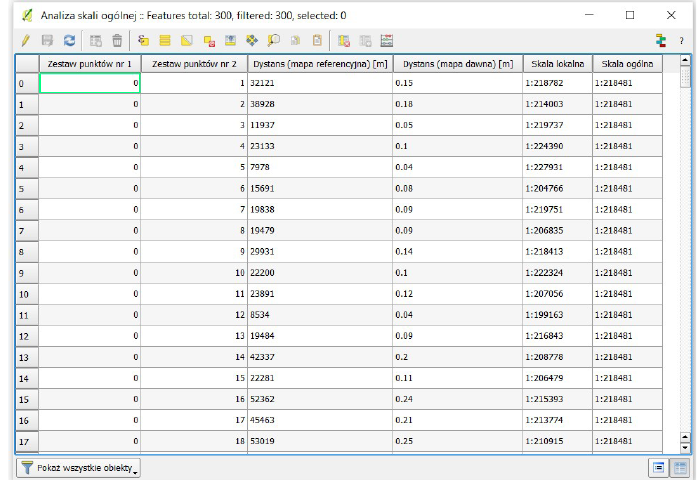
Fig. 8. The result layer attribute table of the algorithm, presenting the general scale for the input data obtained in the program (prepared by M.